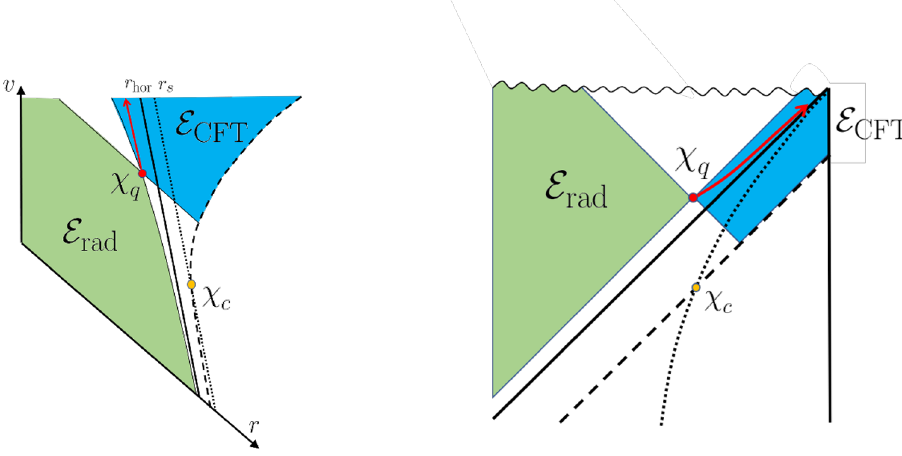
Figure 4. The quantum Ryu-Takayanagi surface (cid:31) q , the classical maximin surface (cid:31) c , and the entanglement wedges E rad and E CFT of the reservoir and CFT, in Eddington-Finkelstein coordinates (left) and in a Penrose diagram (right). In the interests of simplicity, the Penrose diagram does not include the post-evaporation region, which would be in the top right. The classical maximin surfaces lies at the intersection of the past lightcone (dashed) with the apparent horizon r s (dotted), which is outside the event horizon. The quantum RT surface, in contrast, lies slightly inside the event horizon. Much of the interior is in the entanglement wedge E rad of the reservoir (green), although part of the interior still lies in the entanglement wedge E CFT of the CFT (blue). As the black hole continues to evaporate, the RT surface moves forward in infalling time along a spacelike trajectory, following the red arrow. On timescales that are small compared to the evaporation time, it remains a (cid:12)xed radial distance inside the event